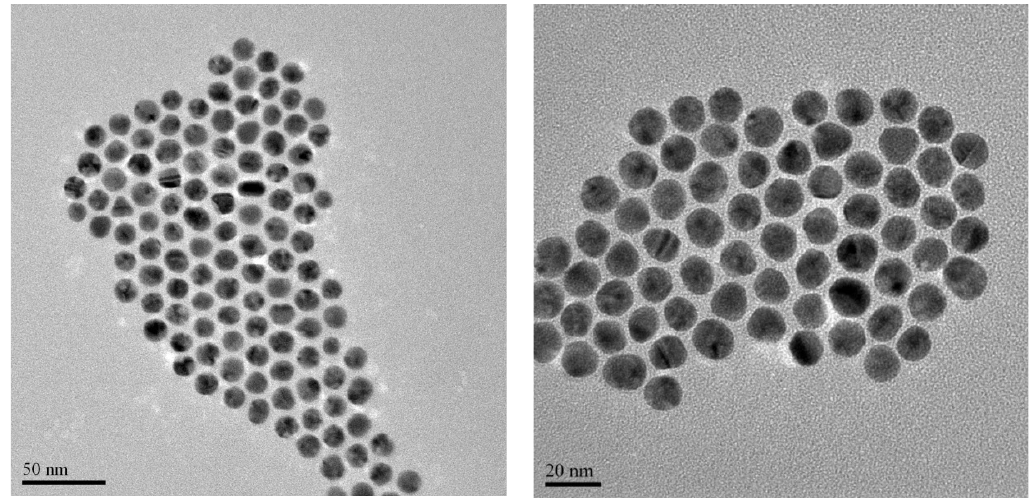
Figure 3. TEM images of PEG-biotin functionalised MPCs at 20 and 50 nm